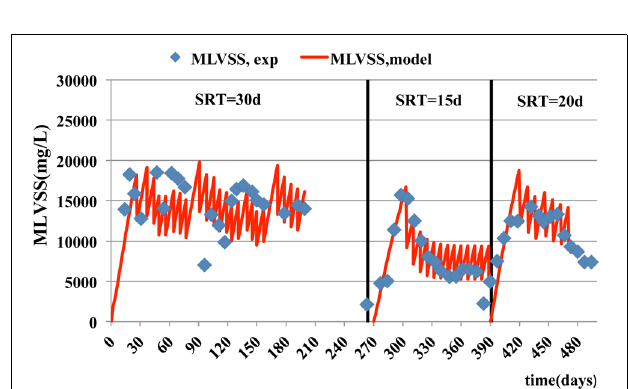
FIGURE 1 | Experimental data and model simulation results for influent (- - - -) and effluent ( ____ ) COD concentrations.